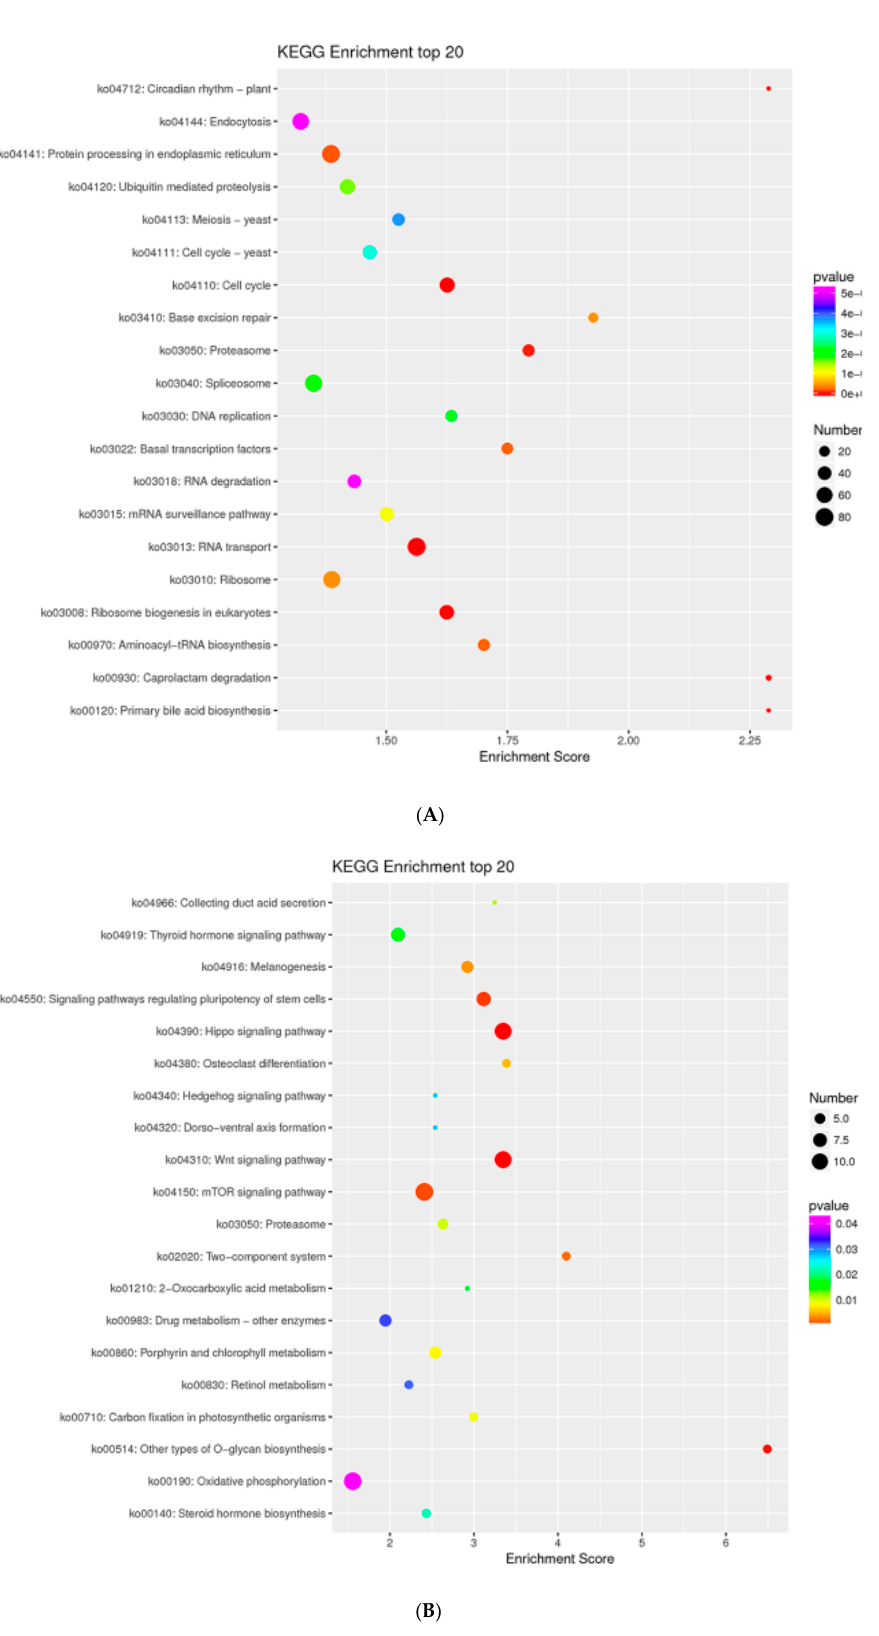
Figure 7. KEGG pathway enrichment of different methylation genes (DMGs) and differentially methylated promoters (DMPs) following HCl treatment. KEGG pathway enrichment of DMGs located in differentially methylated regions (DMRs) ( A ). DMPs located in DMRs ( B ). The circle size represents gene numbers, and the colour represents the Q value.